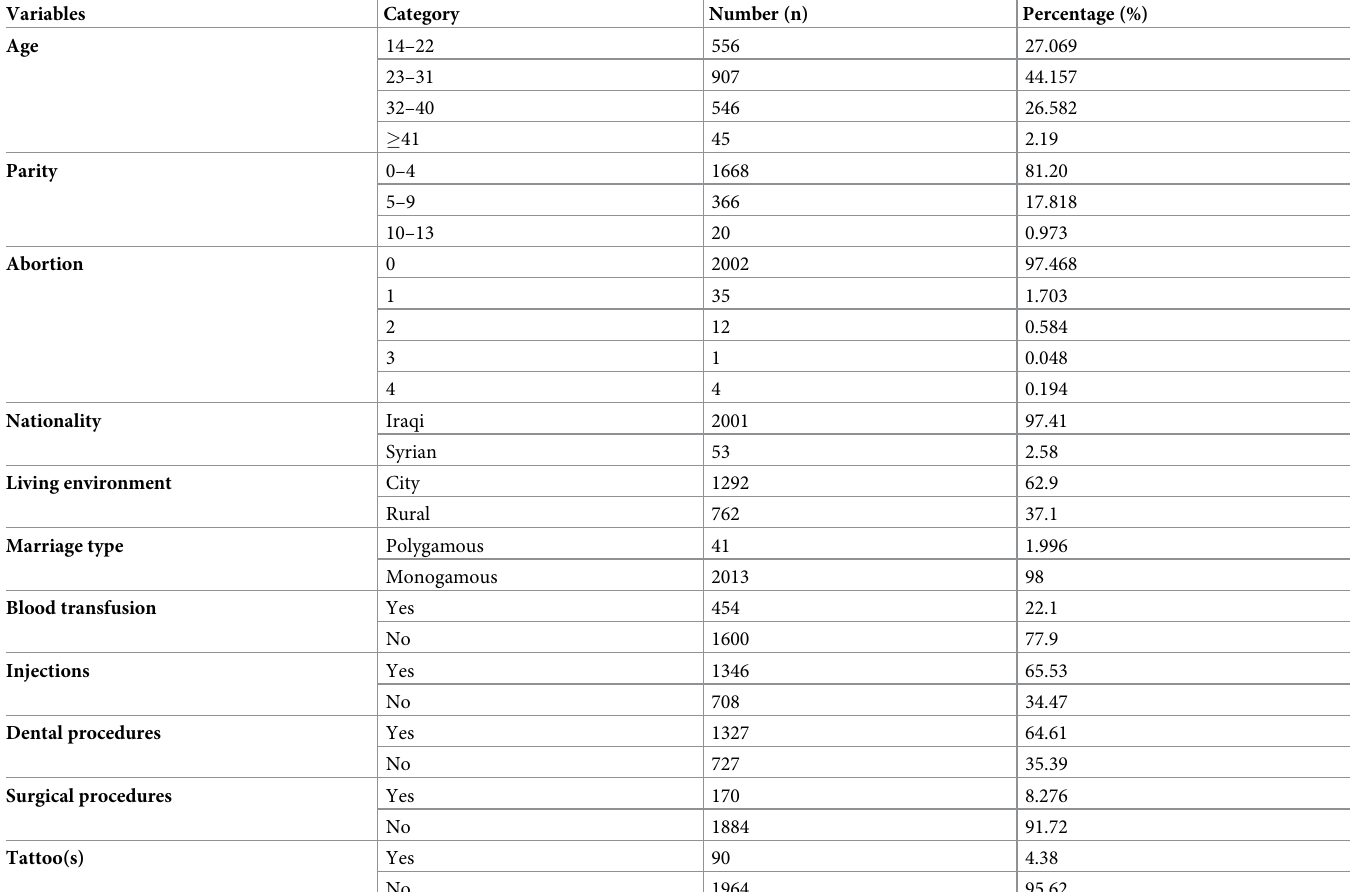
Table 1. Risk factors for HBV